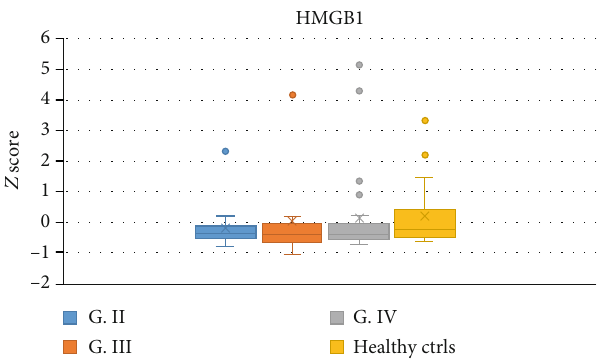
Figure 6: The serum levels of HMGB1 in glioma patients and healthy controls. G: grade; ctrls: